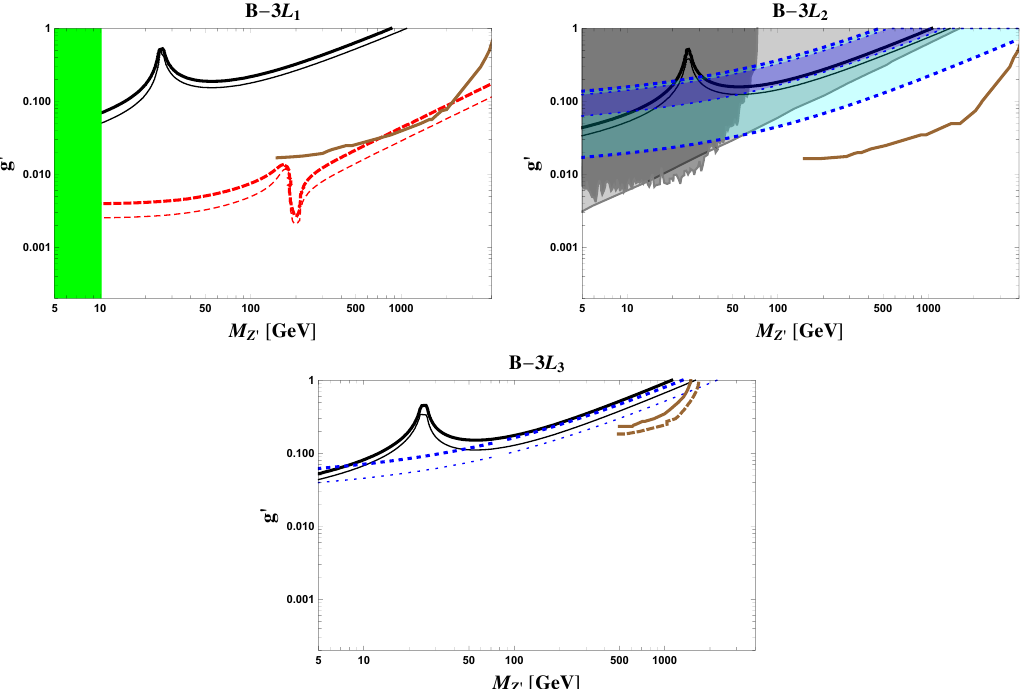
Figure 3 . Upper left panel : bounds on g 0 and M Z 0 for the B (cid:0) 3 L 1 model. The thin (thick) dashed- red and solid-black curves correspond to 1 (cid:27) (2 (cid:27) ) bounds from LEP search [18] and SLD/LEP Z - decay lepton universality test [15], respectively. The green region is excluded by BaBar bounds [19]. The brown curve is the LHC bound from ATLAS observed limits. Upper right panel : bounds on g 0 and M Z 0 for the B (cid:0) 3 L 2 model. The thin (thick) solid-black curve corresponds to 1 (cid:27) (2 (cid:27) ) bound from the SLD/LEP Z -decay lepton universality test [15]. The blue (cyan) shaded region between thiin (thick) dotted-blue curves is the 1 (cid:27) (2 (cid:27) ) allowed region by the HFAG lepton universality test [16]. The brown curve is the LHC bound from ATLAS observed limits. The lighter- and darker- grey regions are excluded by neutrino-trident bound [26, 27] and the LHC bound for Z ! 4 (cid:22) [28]. Therefore, only a small region 60 GeV . M Z 0 . 150 GeV is consistent with all the constraints at 2 (cid:27) . Lower panel : bounds on g 0 and M Z 0 for the B (cid:0) 3 L 3 models. The thin (thick) dotted blue and solid black curves correspond to 1 (cid:27) (2 (cid:27) ) bounds from the HFAG lepton universality test [16] and SLD/LEP Z -decay lepton universality test [15], respectively. The solid and dashed brown curves are the LHC bounds from ATLAS and CMS